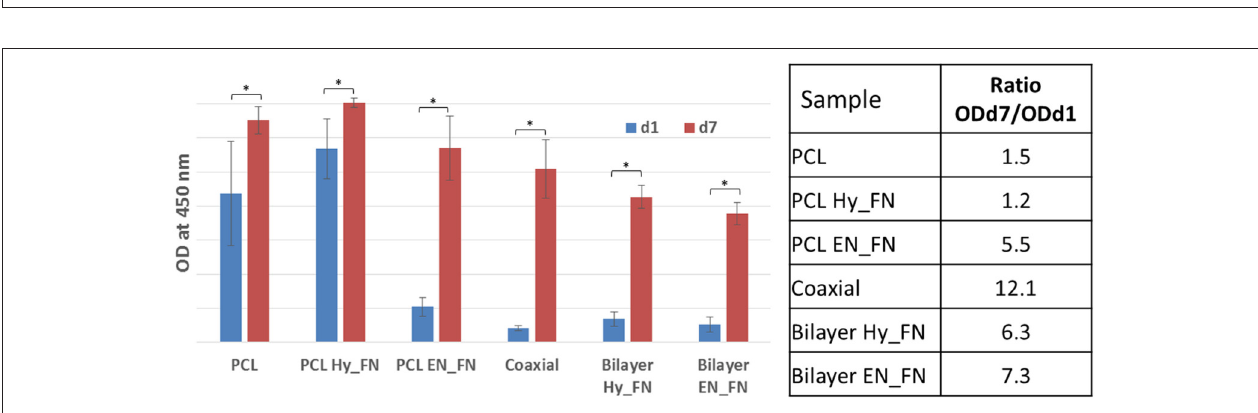
FIGURE 10 | WST-8 analysis: histograms of OD at 450nm for all samples 1 day and 7 days after the seeding. A table reporting the increase of the OD values expressed as ratio between the measured OD 7 days after the seeding respect to the OD measured after 1 day. Asterisk denotes significant difference, p < 0.05.